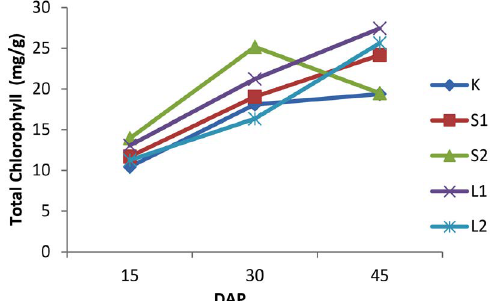
Fig. 3 . Induced compost effect on the relative moisture content. K = control; S1 = Cellulolytic (10%); S2=Cellulolytic (20%); L1 = Ligninolytic (10%); L2 = Ligninolytic (20%).